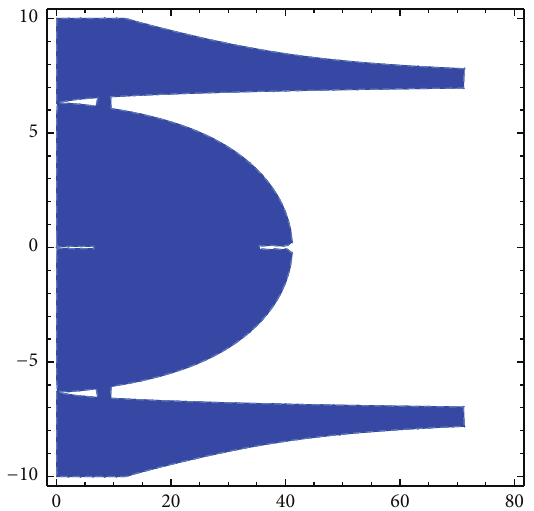
Figure 1: The stability region for the BHT plotted in the (𝑞, 𝑢)